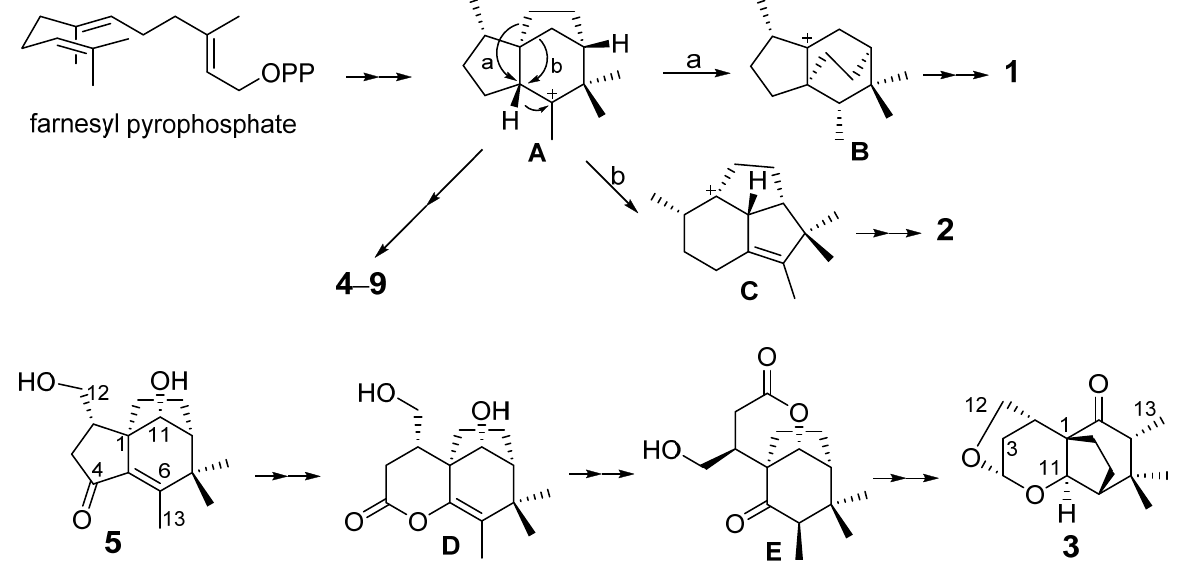
B3LYP/TZVP PCM/MeOH conformers. Bars represent the rotational strength values of conformer